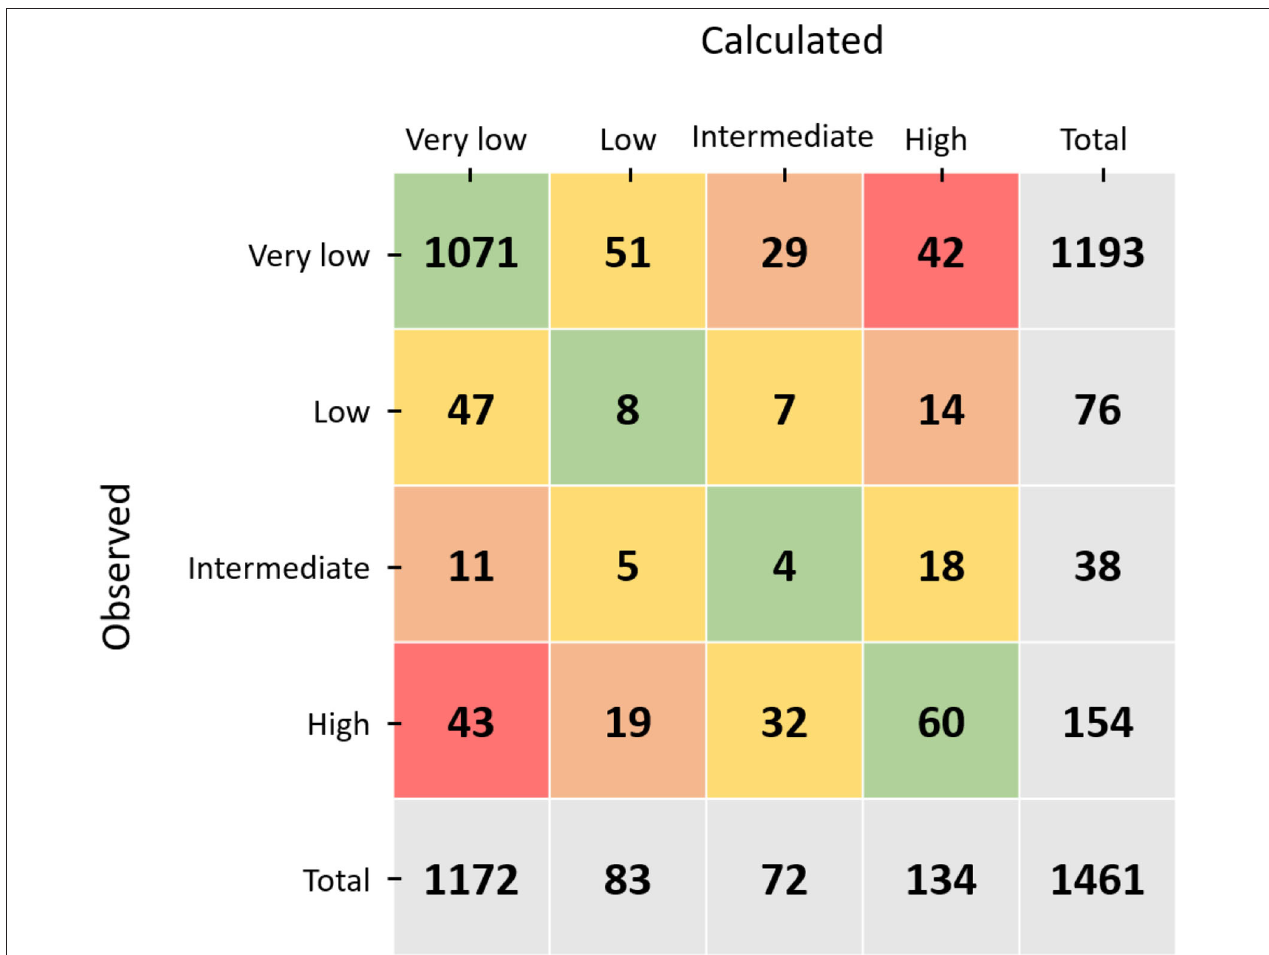
FIGURE 4 | Confusion Matrix of IPSIM-Cirsium. Color of cells are determined with the level of difference between calculated and observed values of weed infestation: Green cells are perfectly matched (0 level of difference), Yellow cells have one level of difference, Orange cells have two levels of difference, and Red cells have three level of differences expressing the furthest distance between calculated and observed values of weed